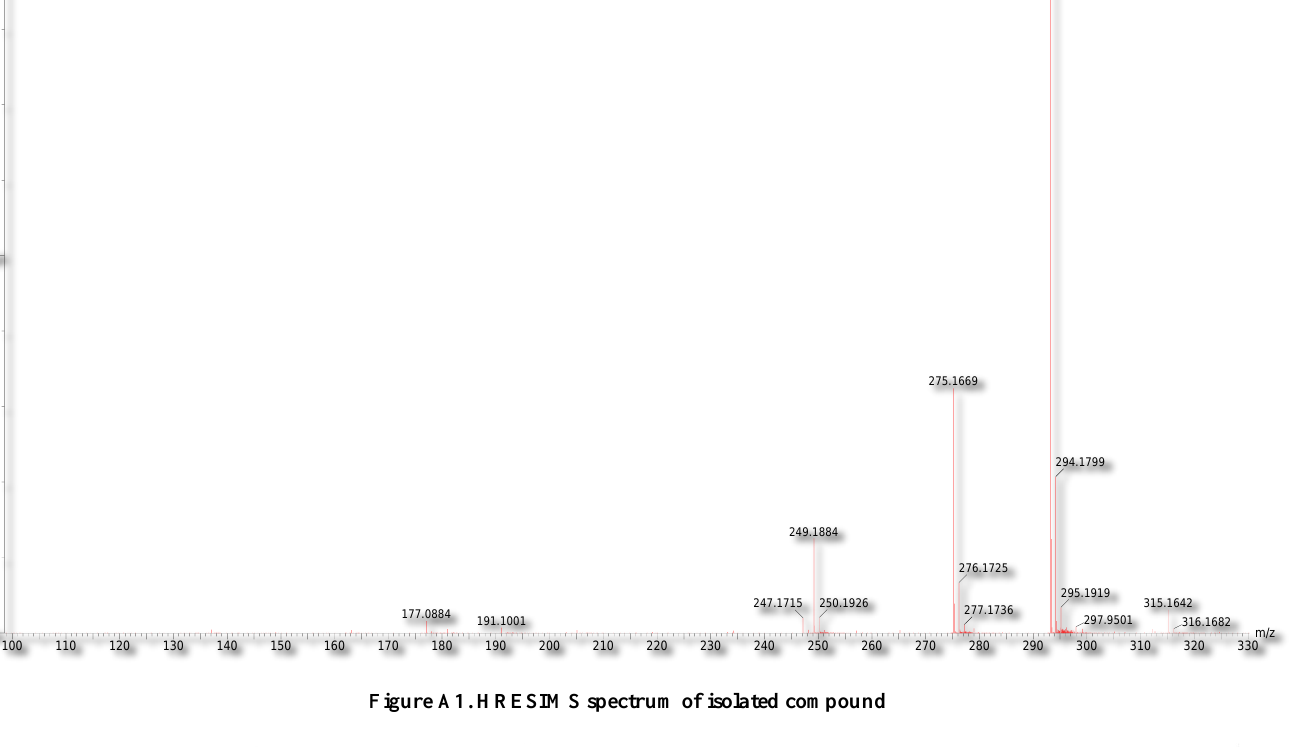
Figure A1. HRESIMS spectrum of isolated compound